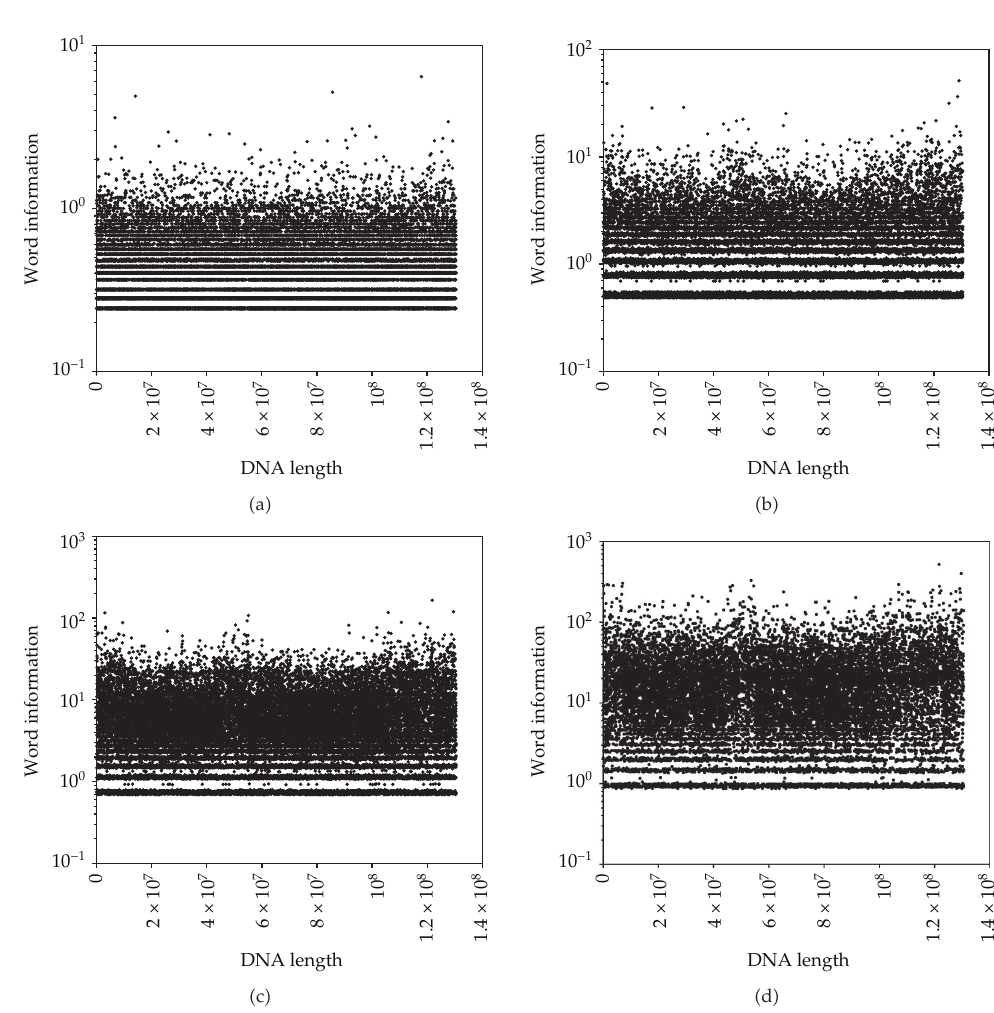
Figure 4: Word information versus length for the Ho12 and n (cid:7) { 1 , 2 , 3 , 4 }